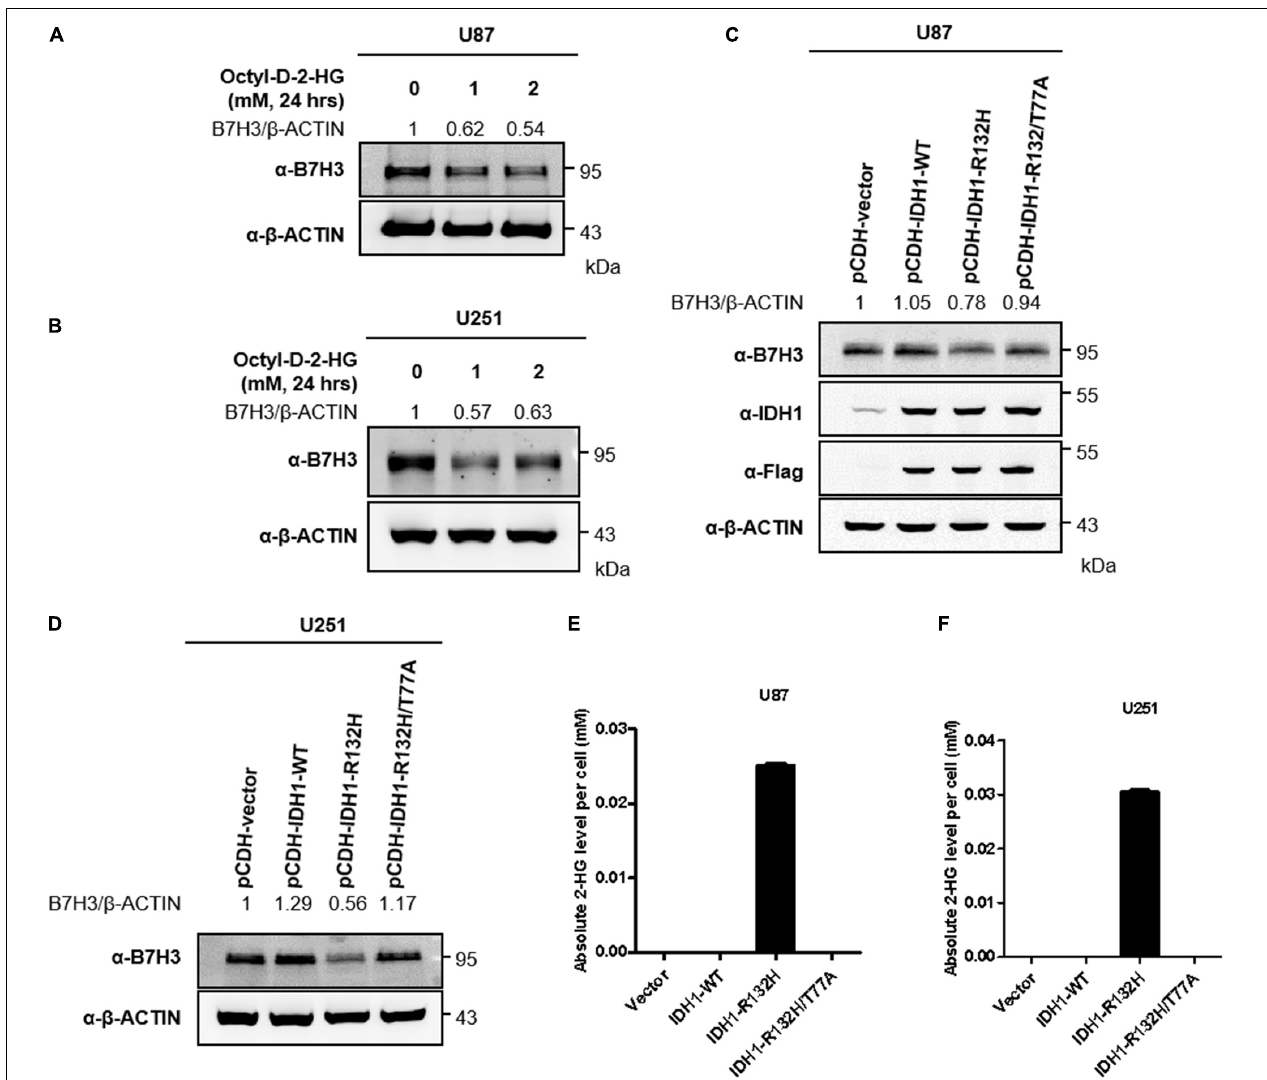
FIGURE 2 | 2-HG accumulation leads to B7H3 downregulation in U87 and U251 cells. (A) B7H3 is decreased after 2-HG treatment in U87 cell line. Cells were collected after cell-permeable octyl-D-2HG treatment for 24 h, and immunoblotting was performed with the indicated antibodies. (B) B7H3 is reduced after 2-HG treatment in U251 cell line. Cells were collected after cell-permeable octyl-D-2HG treatment for 24 h, and immunoblotting was performed with the indicated antibodies. (C) B7H3 is decreased in stable IDH1-R132H U87 cell line. Stably expressed IDH1-WT, IDH1-R132H, and IDH1-R132H/T77A U87 cells were constructed. After cell collection, immunoblotting was performed with the indicated antibodies. (D) B7H3 is reduced in stable IDH1-R132H U251 cell line. Stably expressed IDH1-WT, IDH1-R132H, and IDH1-R132H/T77A U251 cells were constructed. After cell collection, immunoblotting was performed with the indicated antibodies. (E,F) Absolute 2-HG levels in stable U87 and U251 cell lines. Vector, IDH1-WT, IDH1-R132H, and IDH1-R132H/T77A U87 (E) and U251 cells (F) were collected and subjected to LC-MS/MS for 2-HG measurement as described in section “Materials and Methods.” All experiments were performed in triplicate and representative results were